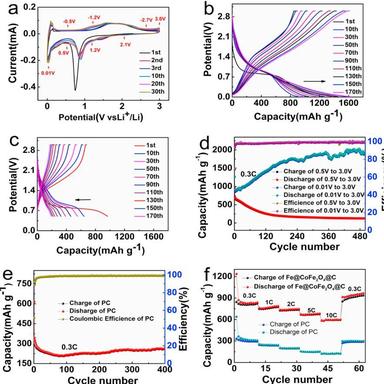
(a) CV curves, (b) charge and discharge profiles between 0.01 V and 3.0 V), (c) charge and discharge profiles between 0.5 V and 3.0 V and (d) the cycling performances between 0.01 V and 3.0 V and 0.5 V and 3.0 V of Fe@CoFe2O4@C electrode; (e) the cycling performances of PC electrode; (f) rate performances of Fe@CoFe2O4@C and PC electrodes at different current densities.